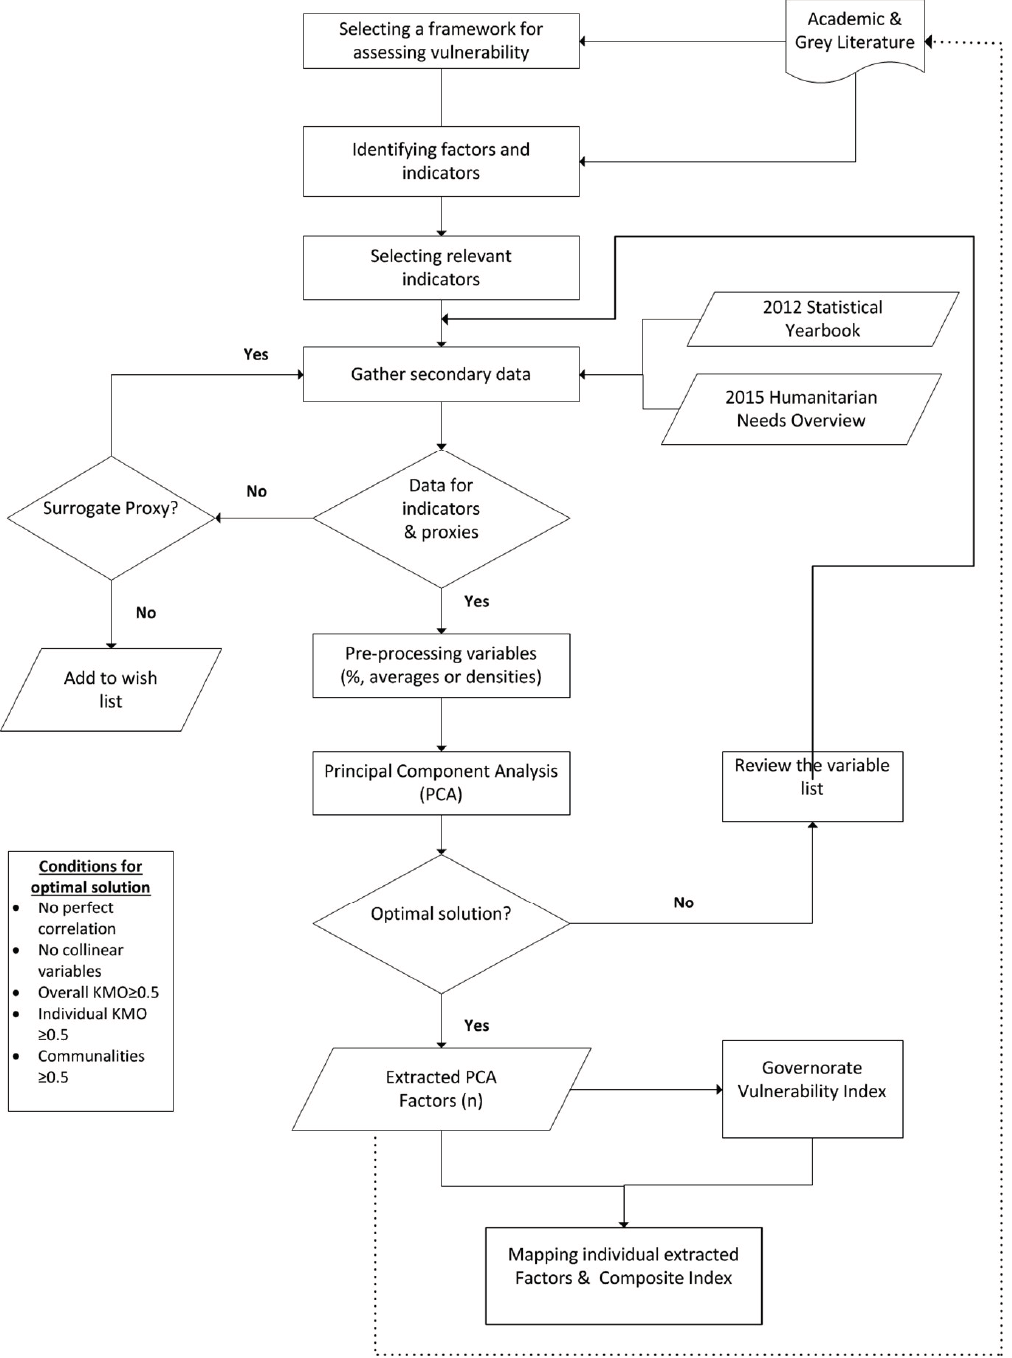
Figure 3. Methodology for assessing social vulnerability of governorates in